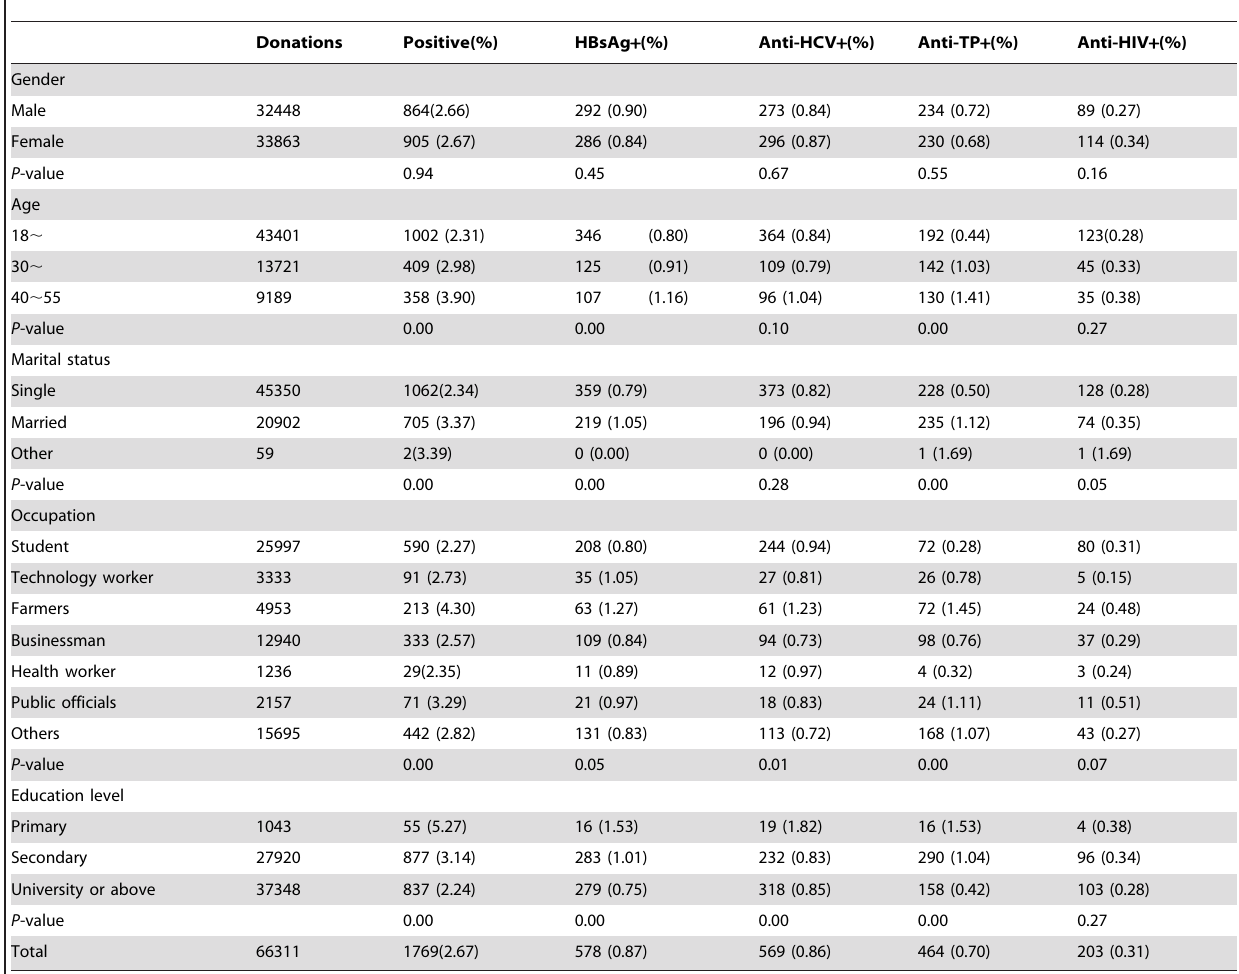
Table 4. Positivity rate of transfusion-transmissible infections, by demographic characteristics,